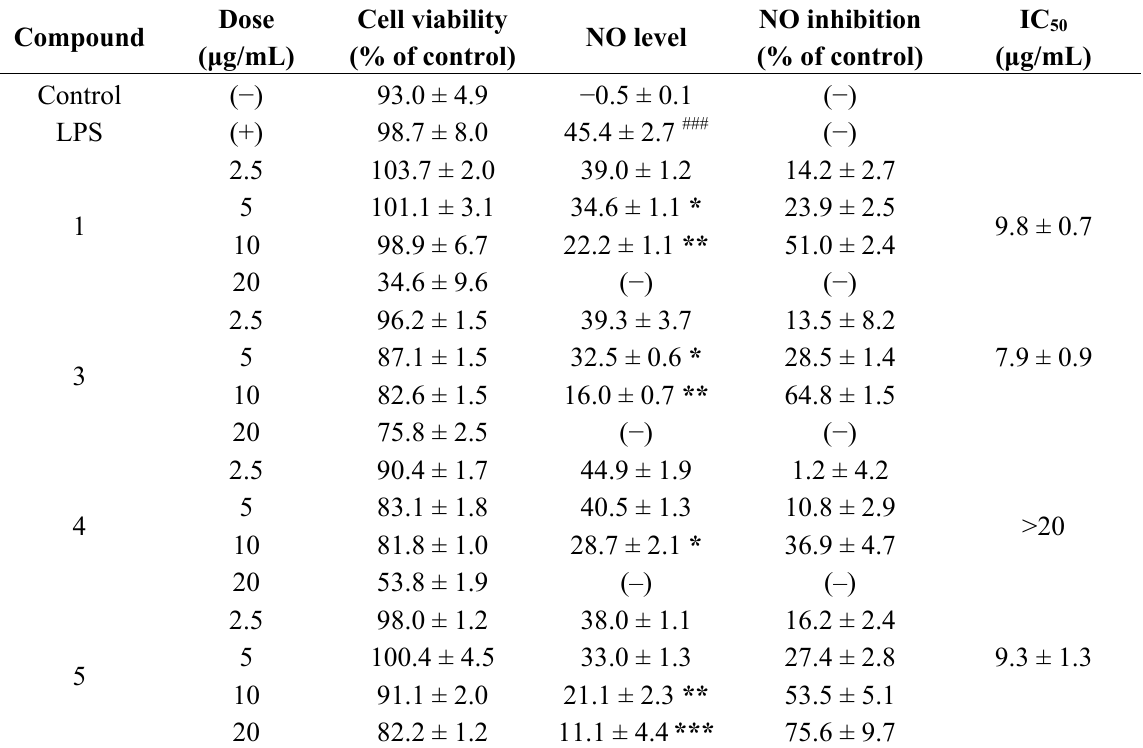
Table 2. Cell viability and effect of compounds 1 , 3  5 on LPS-induced NO production in macrophages a . Dose Compound